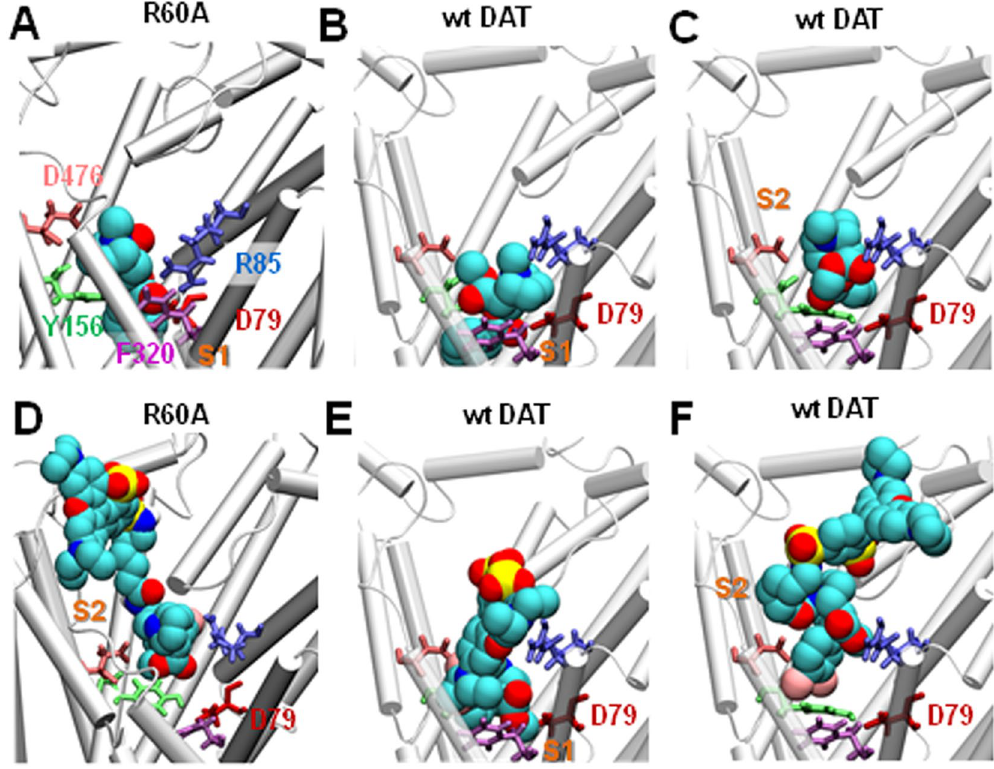
Figure 6. Cocaine and its analog bind and stabilize the outward-facing (OF) state to the wt DAT and the R60A mutant. ( A ) Cocaine binds near the S1 site of R60A in the OF state of the mutant, and closely interacts with D79, R85, Y156, F320 and D476. ( B,C ) Cocaine binds near the S1 ( B ) and S2 ( C ) sites of wt DAT in the OF state. ( D ) JHC1-64 binds near the S2 site of R60A and inserts toward the S1 site. (E,F) JHC1-64 binds to the vicinity of the S1 ( E ) and S2 ( F ) sites of wt DAT. Cyan, blue, dark red, light red , and yellow spheres represent the respective carbon, nitrogen, oxygen, chloride, and sulfur atoms of